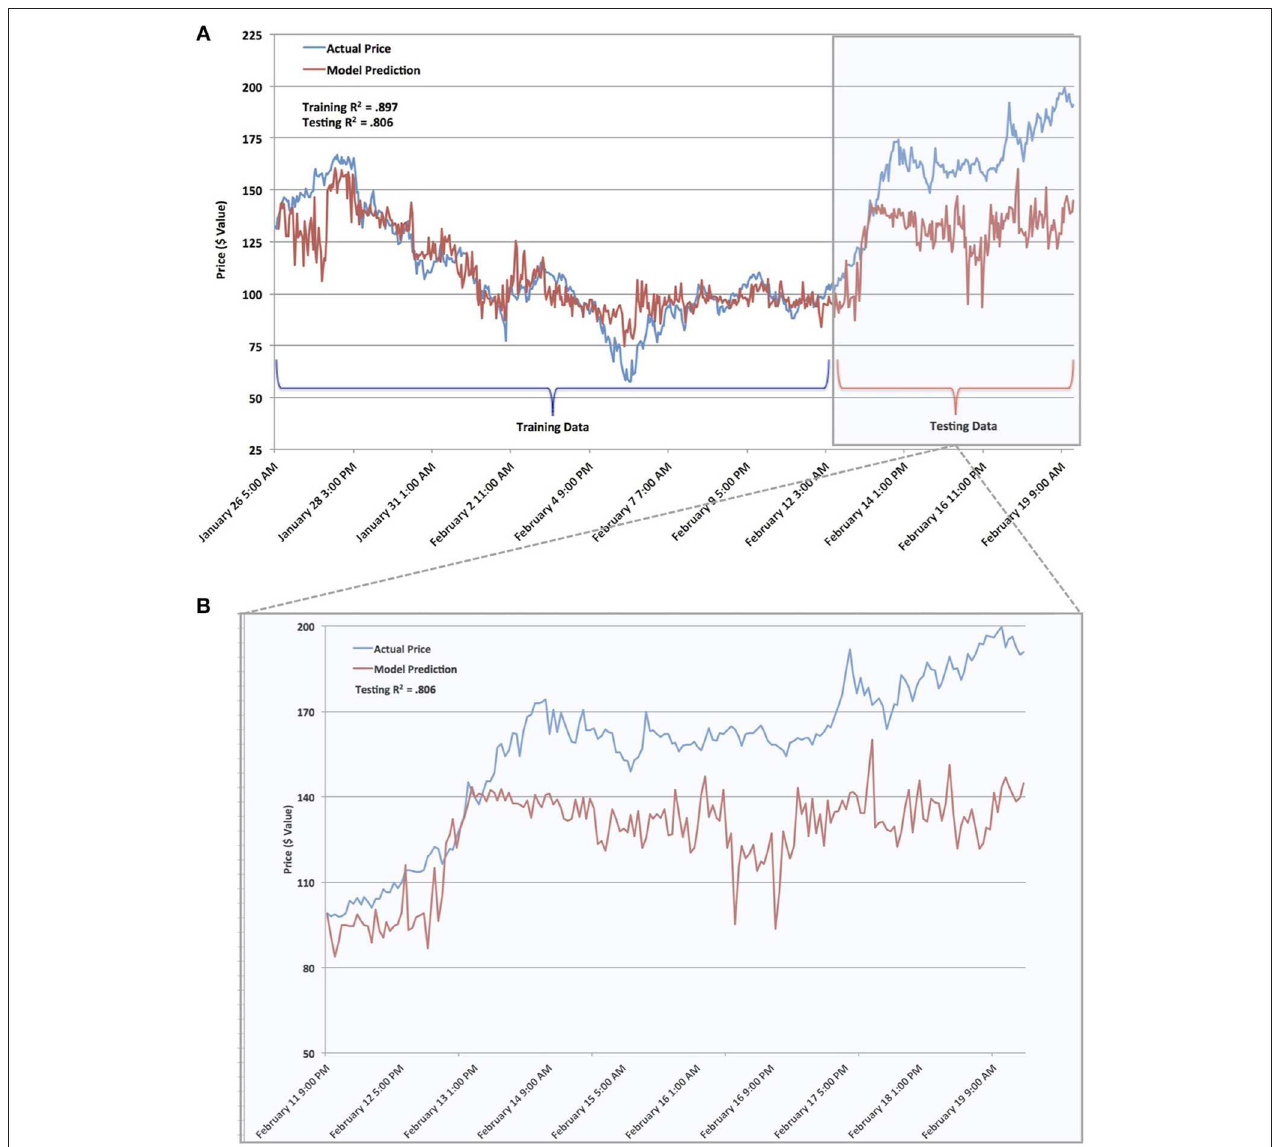
FIGURE 2 | Comparison of model prediction and actual price data. (A) plots the fitted price curve obtained from the training price data and the predicted price curve with respect to the testing data. (B) details the model prediction price data as compared to the testing real price data. By incorporating Twitter sentiment and trading volume, the Extreme Gradient Boosting Regression Tree Model provides a viable means of predicting price fluctuations within the ZClassic cryptocurrency market. Moreover, it serves as a proof of concept that statistical analyses using Twitter sentiment can also be used to analyze price fluctuations in other cryptocurrencies of interest.